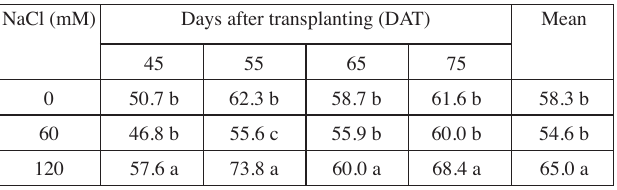
Tab. 4: Effect of NaCl salinity on the free radical scavenging activity (%) by antioxidants in the extract of foliar tissue of cape gooseberry plants between 45 and 75